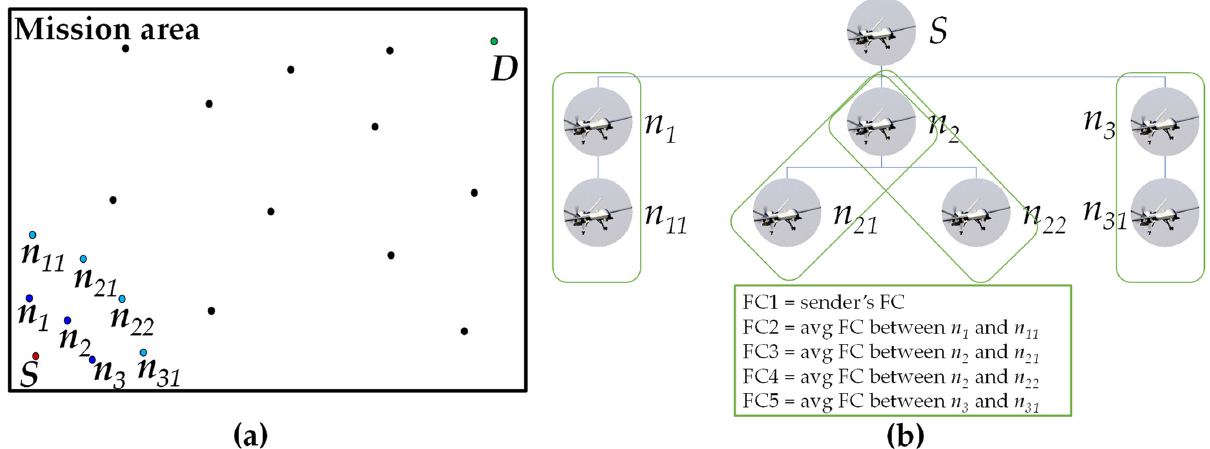
Figure 10. Simplified 2D example of FC calculation: ( a ) sample mission scenario and ( b ) sample FC calculation method.